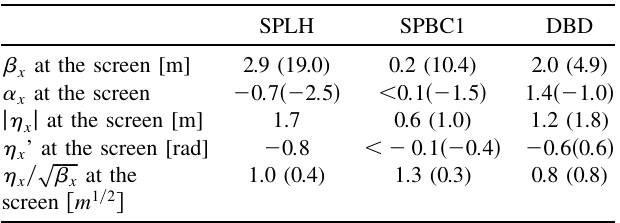
ELECTRON BEAM OPTICS AND TRAJECTORY CONTROL . . TABLE II. Design optical parameters of the three spectrome- ter lines in the FERMI main linac. For comparison, the values in parentheses refer to the optics used for FEL production, not for the energy spread measurement.